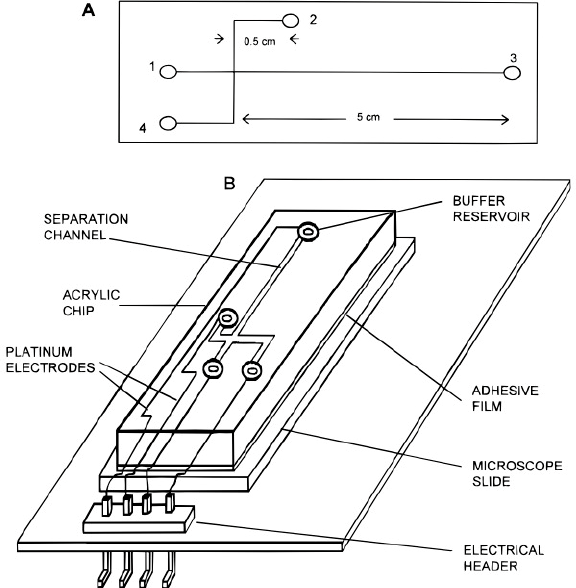
Figure 10. Design of the plastic microchannel chip ( A ) and ichnography ( B ) the details of the completed chip. Reprinted with permission from reference [152]. (Copyright, 1997, American Chemical Society).